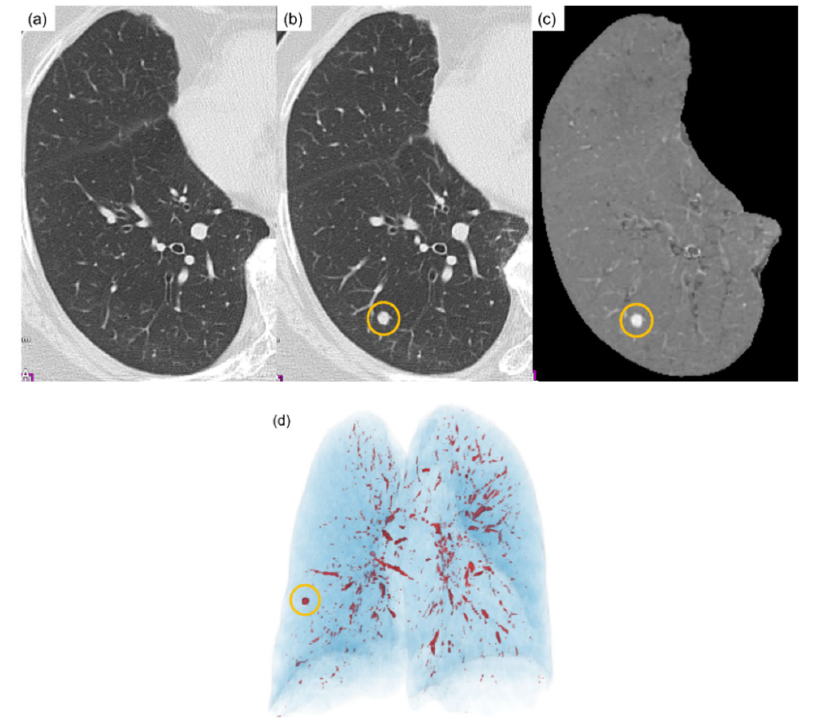
Figure 6. Result images applied the proposal method to the current and previous CT images pair. ( a ) Shows a section of previous CT images, ( b ) a section of current CT images, ( c ) a section of temporal subtraction images, and ( d ) a volume rendering capture image of temporal subtraction images. The lesion is circled. Table 1. The range of the loss function values for the training sets.